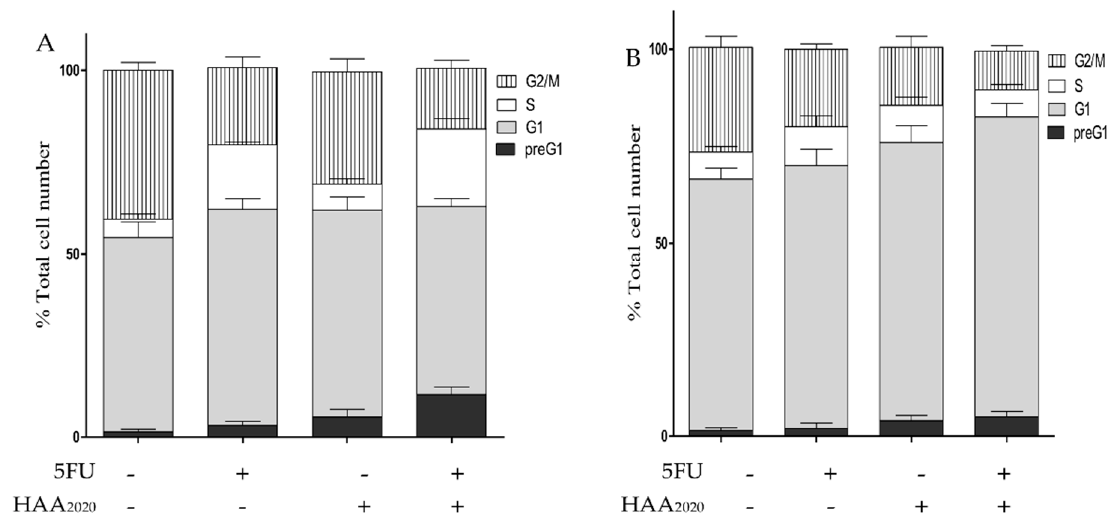
Figure 8. Cell cycle analysis of ( A ) HT29, and ( B ) HT29-5FU cells (mean ± SD, n = 3) treated for 72 h with either vehicle, 5FU (0.25 µM), HAA 2020 (3 µM), or 5FU (0.25 µM) + HAA 2020 (3 µM).